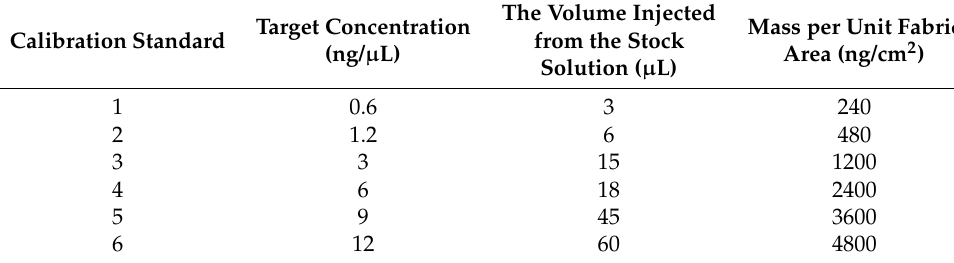
Table 4. Calibration solutions for the chromatography